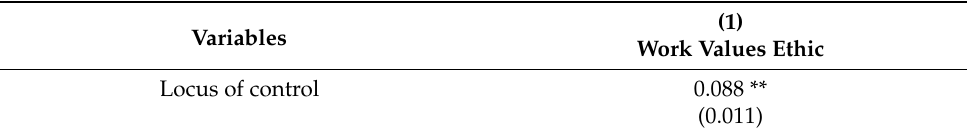
Table 3. Locus of control and work values ethic.